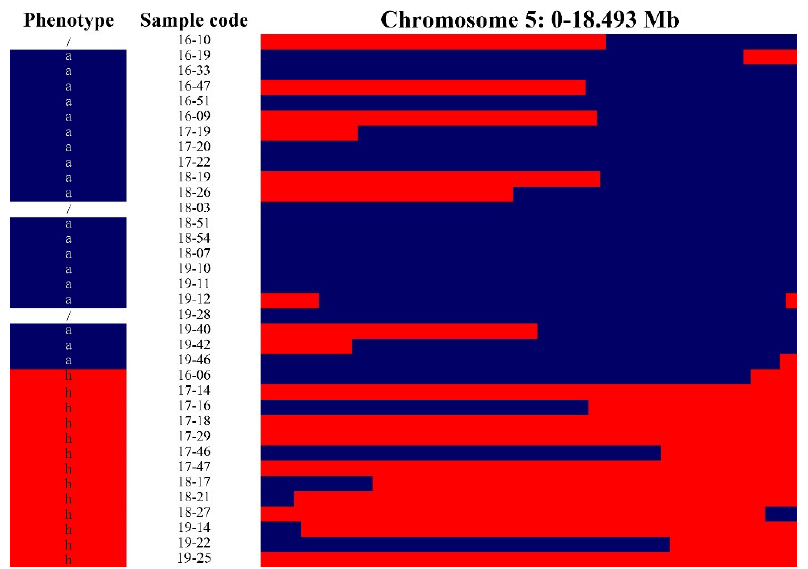
Figure 2. Mapping of the locus based on the genotyping and phenotype of 38 BC 1 introgression individuals and two parents. Red indicates the introgression fragment from “Baihuahsanbitao”, blue indicates the fragments from “Zhongyou No. 4”. The letter “a” indicates homozygous nectarines; “h” indicates heterozygous peaches.